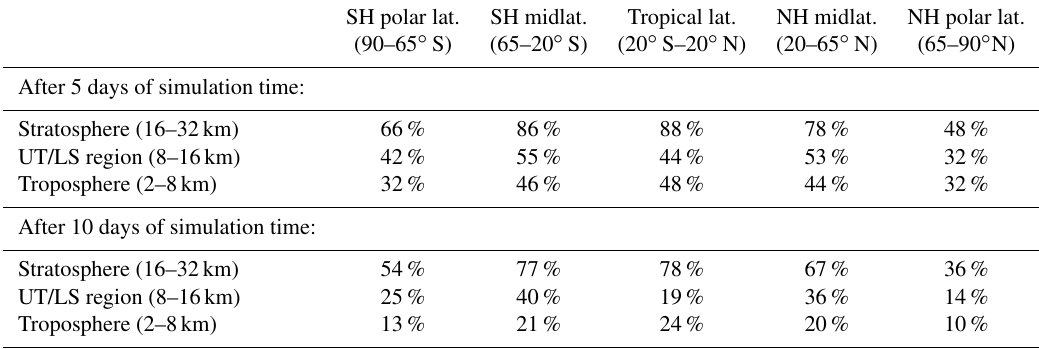
Table 1. Fractions of air parcels remaining in initial regions during the course of the simulations. SH indicates the Southern Hemisphere and NH indicates the Northern Hemisphere. SH polar lat. SH